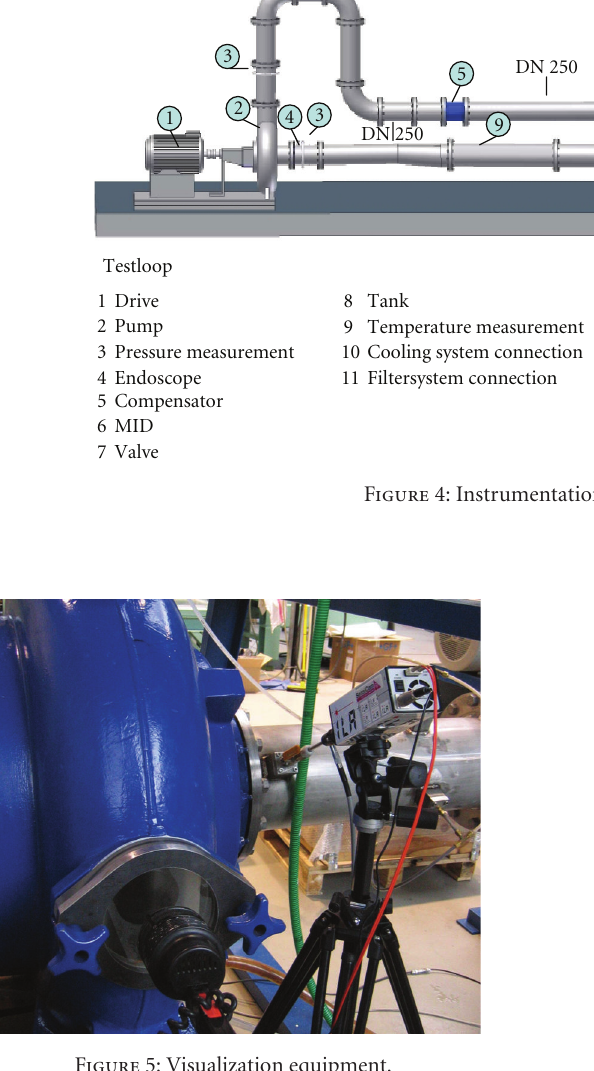
Figure 5: Visualization equipment.